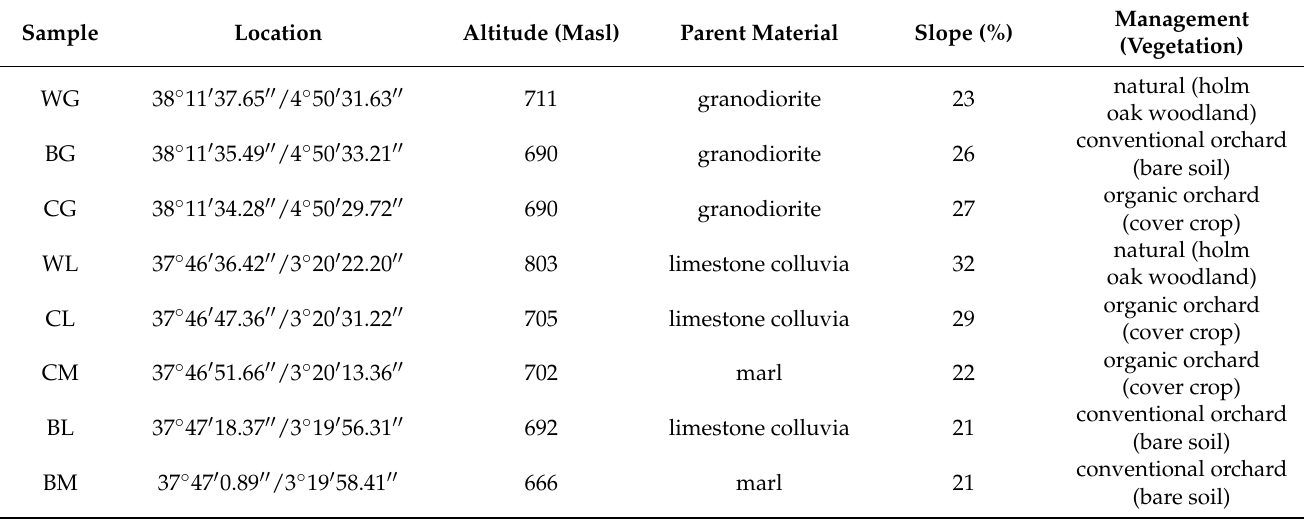
Table 1. Some characteristics of the sampled plots. W stands for forest; B and C for olive groves with bare soil or with spontaneous cover crops, respectively. G, L and M stand for siliceous and calcareous limestones or calcareous marl, respectively. Masl stands for meters above sea